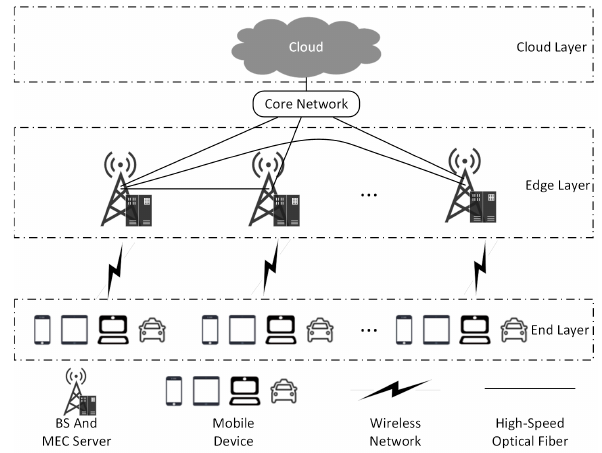
Figure 1. MEC system model of cloud–edge–end collaboration. Table 2. Main used